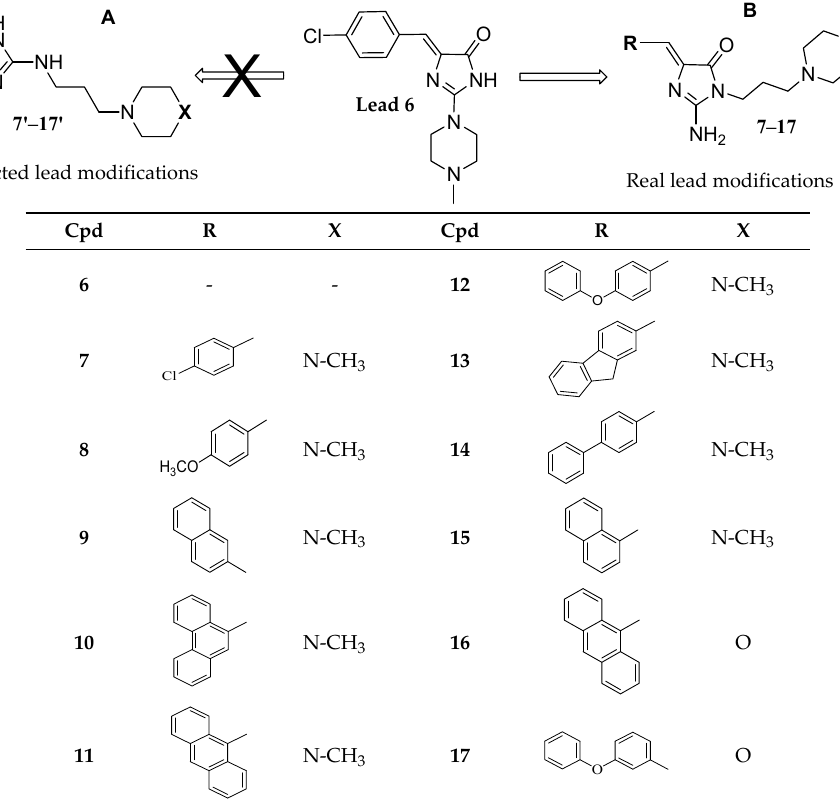
Table 1. Structure of investigated compounds: lead 6 and its modifications ( 7 – 17 ).